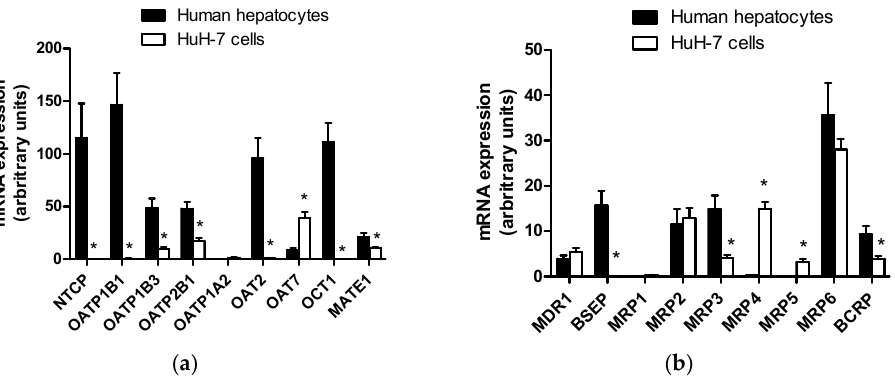
Figure 1. Solute carrier SLC ( a ) and ATP-binding cassette (ABC) ( b ) drug transporter mRNA expression in HuH-7 cells. Drug transporter mRNA expression was determined by RT-qPCR in human hepatoma HuH-7 cells and in freshly isolated human hepatocytes. Data are expressed as arbitrary units and are the means + SEM from at least three independent assays (HuH-7 cells) or from three independent populations (human hepatocytes). * p < 0.05 when compared to transporter mRNA expression level found in freshly isolated human hepatocytes (Student’s t -test).